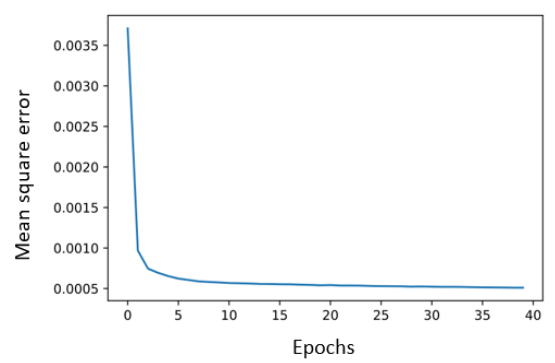
Figure 9. Training MSE, Case 1